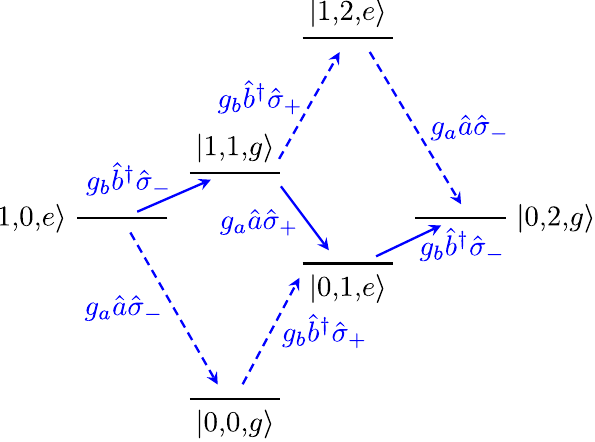
Figure 8. The lowest-order processes contributing to a transition between |1, 0, e 〉 and |0, 2, g 〉 in the quantum Rabi model. The transitions that do not conserve excitation number are shown as dashed blue lines and the excitation-number-conserving transitions are shown as solid blue lines. The label of each line is the term in Eq. (6) that gives rise to that transition. The parameters ω a = 3 ω q and ω b = 2 ω q were used to set the positions of the energy